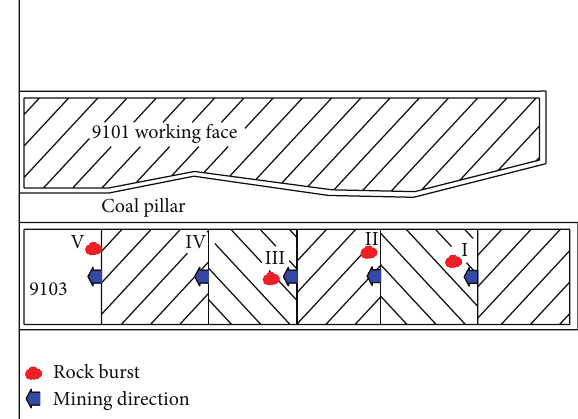
Figure 4: Spatial relation between microearthquake and mining.